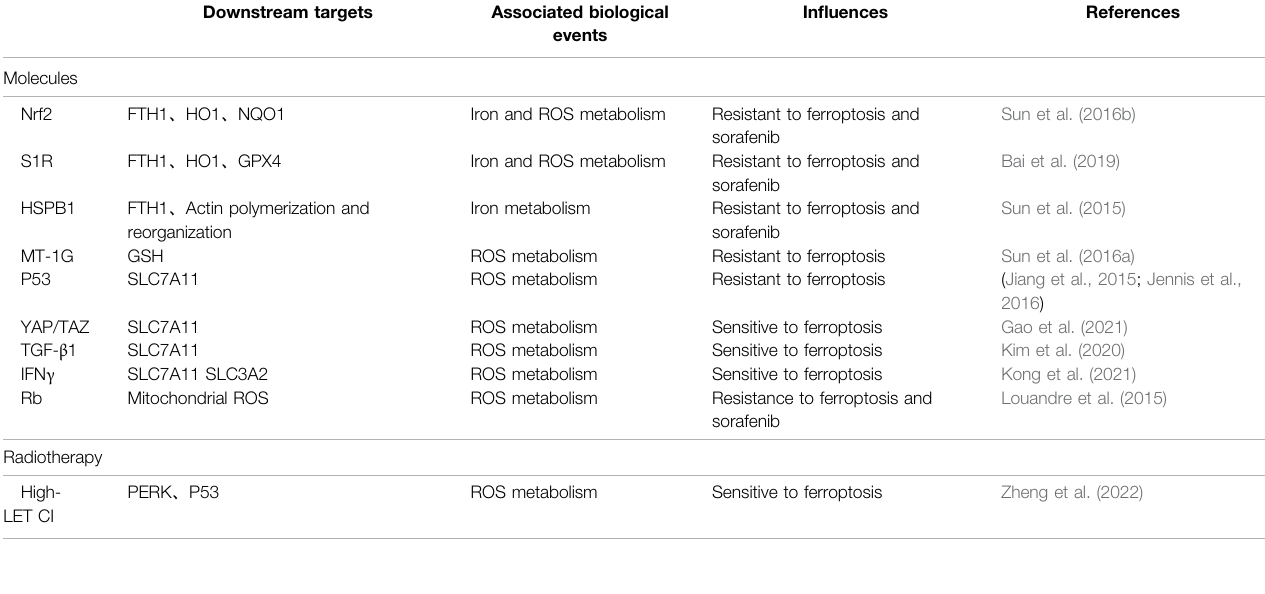
TABLE 1 | Some typical molecules and radiotherapy are involved in regulation of ferroptosis in HCC. Downstream targets